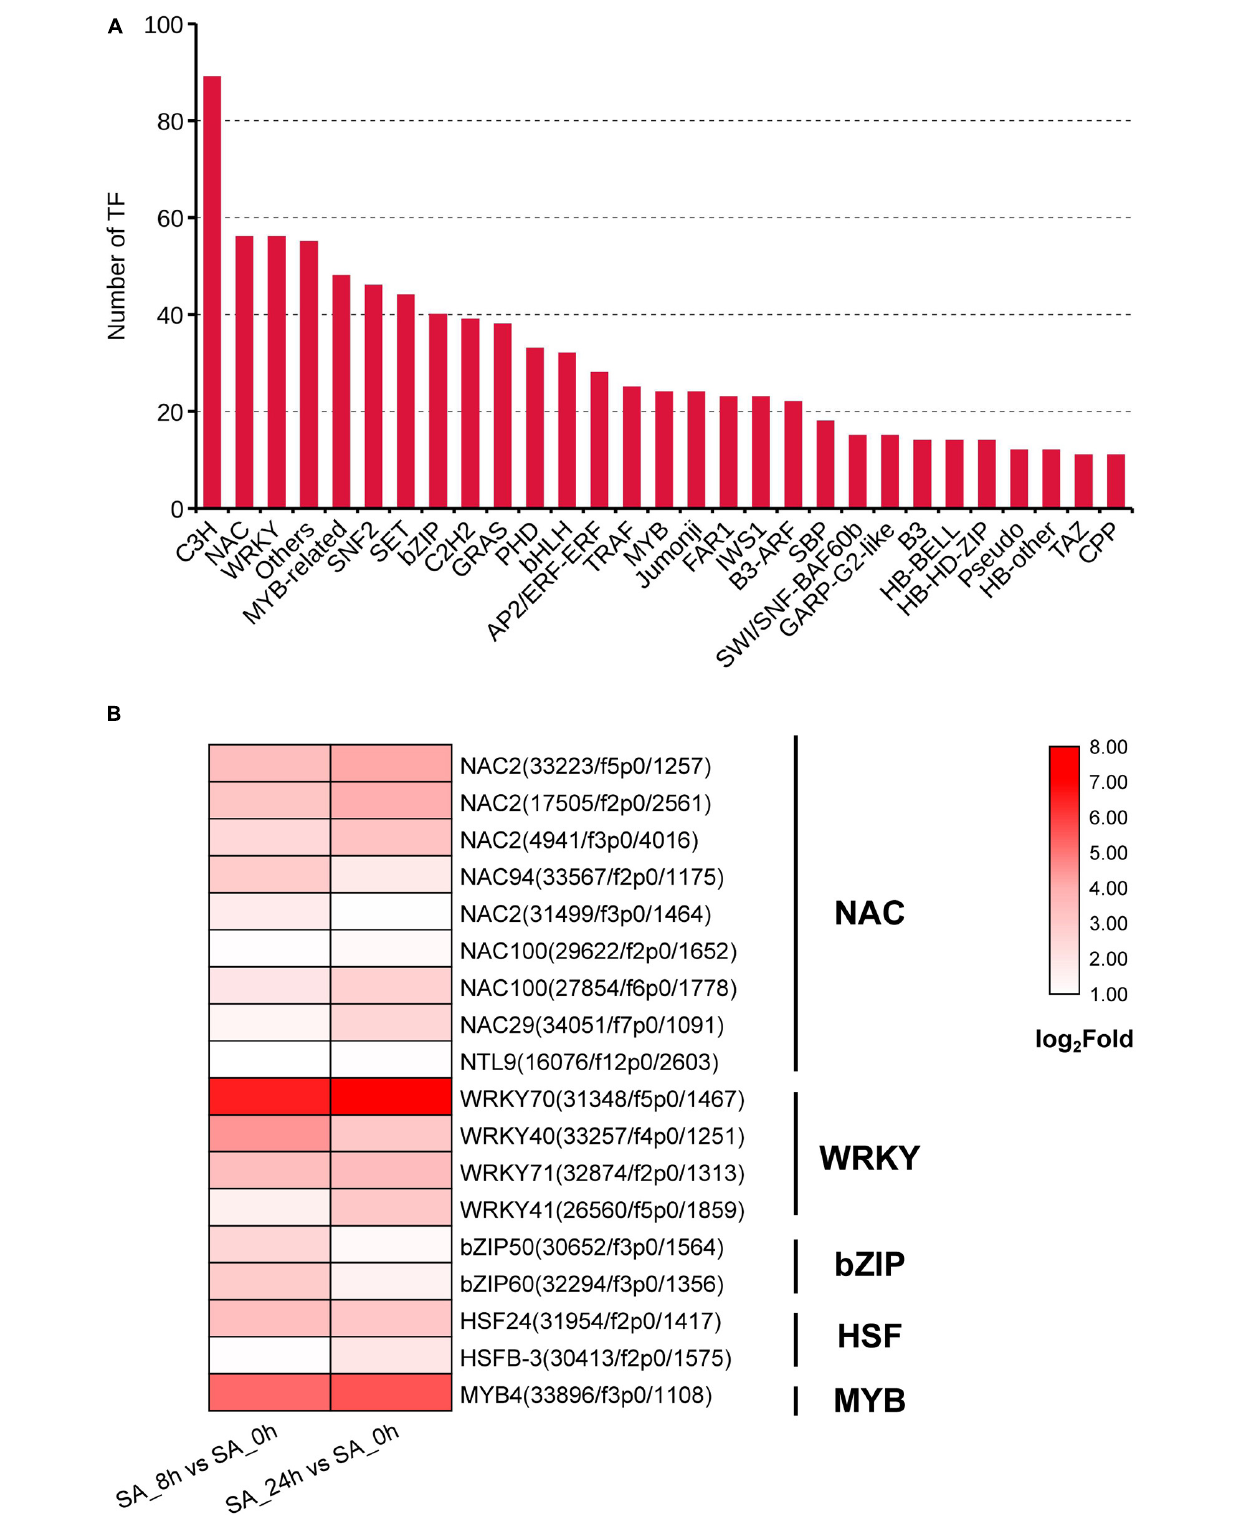
FIGURE 6 | Identification of transcription factor (TF) families. (A) The unigene numbers annotated to TF families. (B) The heat graph shows the up-regulated TF genes belong to NAC, WRKY, bZIP, HSF and MYB families under SA treatments. The fold changes for two comparison types (SA_8h vs. SA_0h and SA_24h vs. SA_0h) were log 2